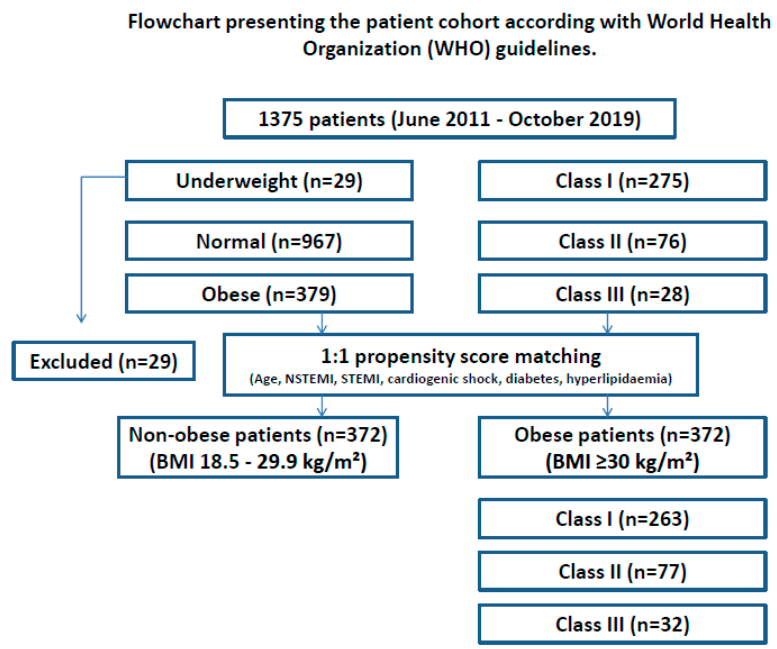
Figure 1. Flowchart presenting the patient cohort according to the World Health Organization (WHO) guidelines before and after PSM. BMI—body mass index, PSM—propensity score matching, n—number of patients.